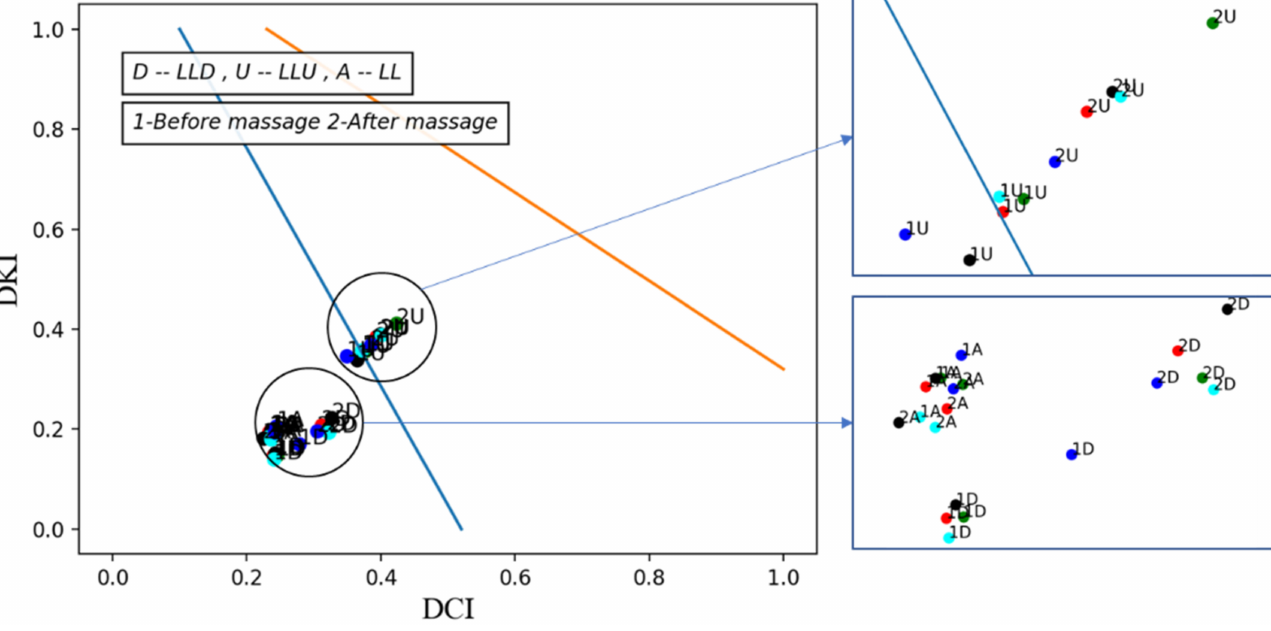
Figure 8. Type of vascular tone of the right leg (non-massaged) before and after the